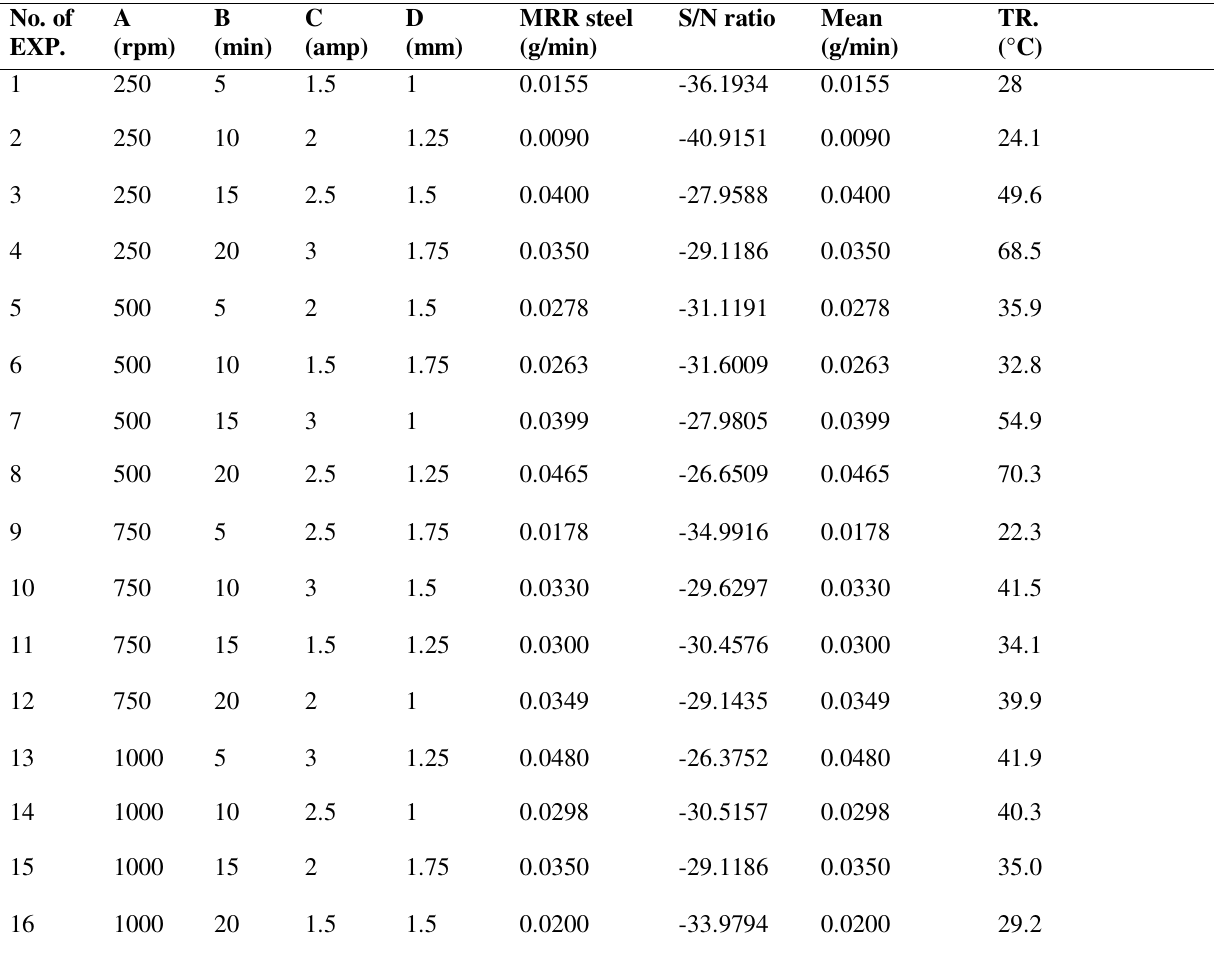
Design of the experiments and result of the mean, S/N ratio for MRR the stainless steel